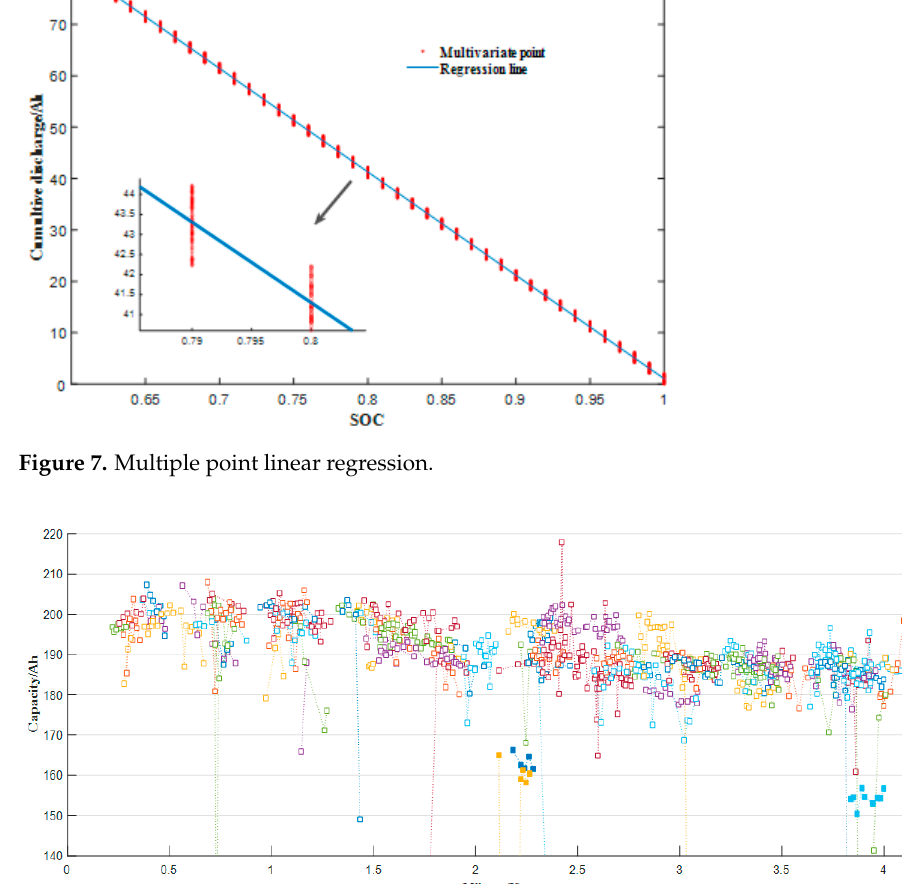
Figure 7. Multiple point linear regression.